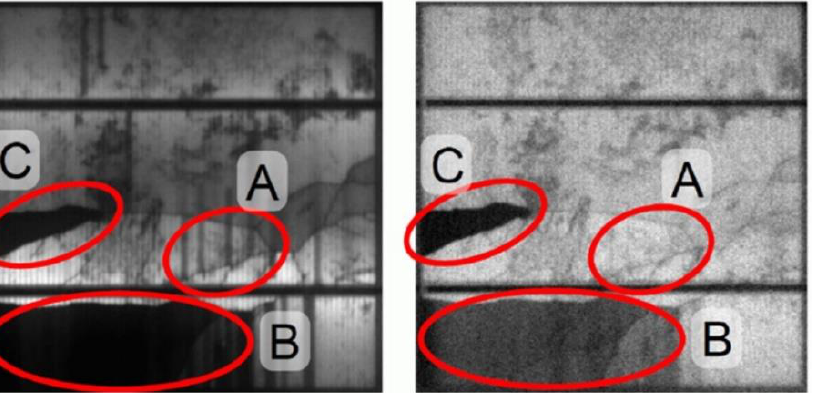
Figure 2. Electroluminescence (EL) images of the same solar cell with crack modes A, B, and C. ( Left ) EL image taken at the short-circuit current. ( Right ) EL image taken at 10% of the short-circuit current obtained from [ 16 ].